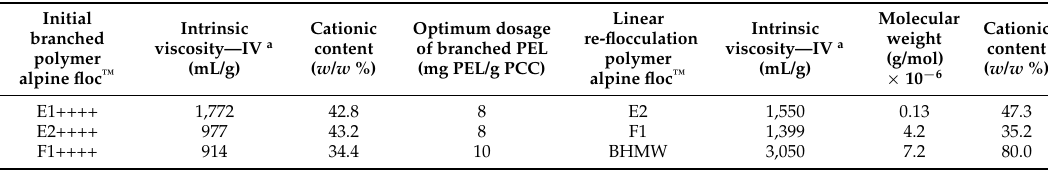
Table 1. Flocculants